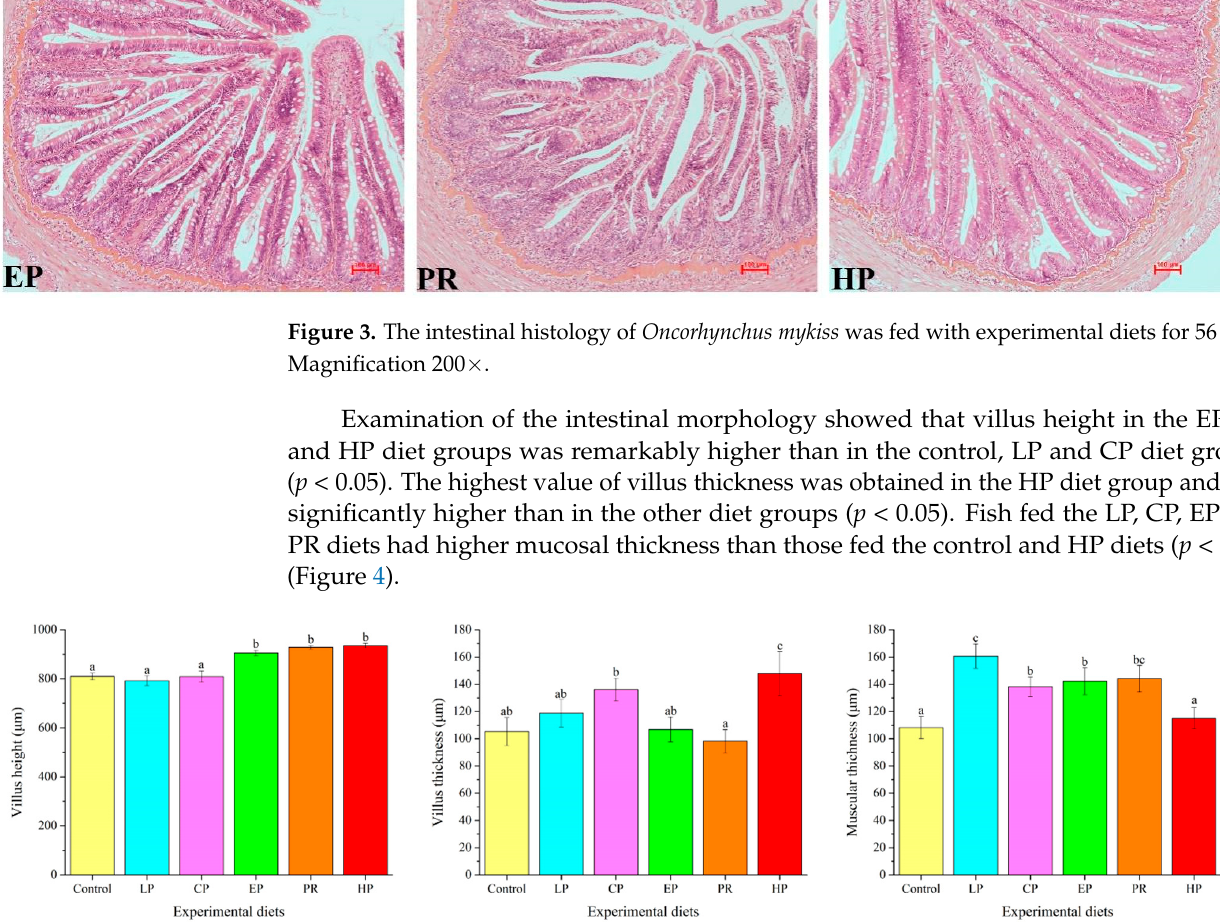
Figure 4. Effects of different diet treatments on the intestinal morphometry of Oncorhynchus mykiss . Values are presented as mean ± SE, n = 12. The superscript letters indicated significant differences at p < 0.05.